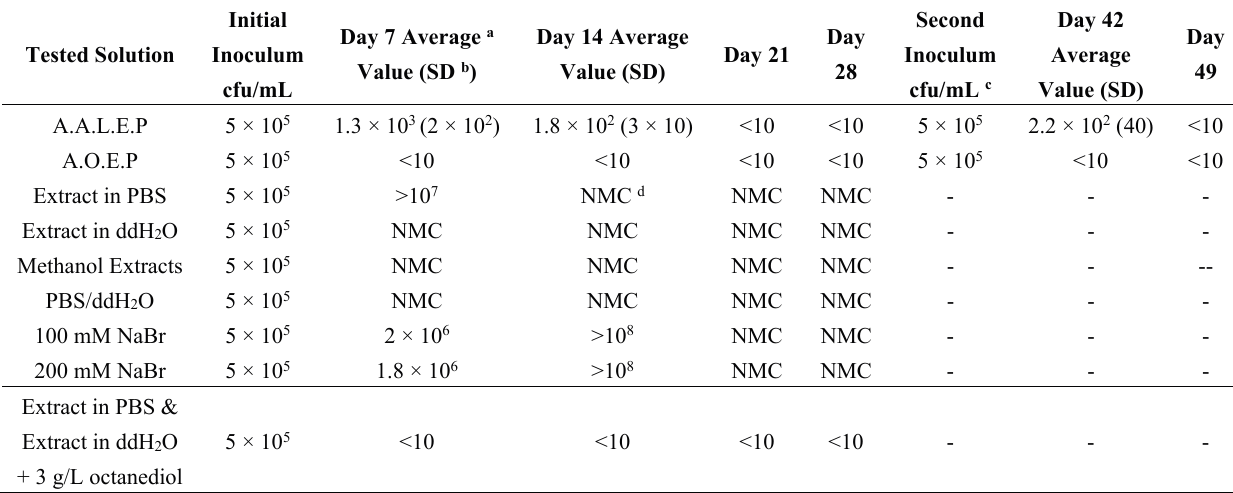
Table 1. Bactericidal activity of different Cornus mas L. extracts against S. aureus